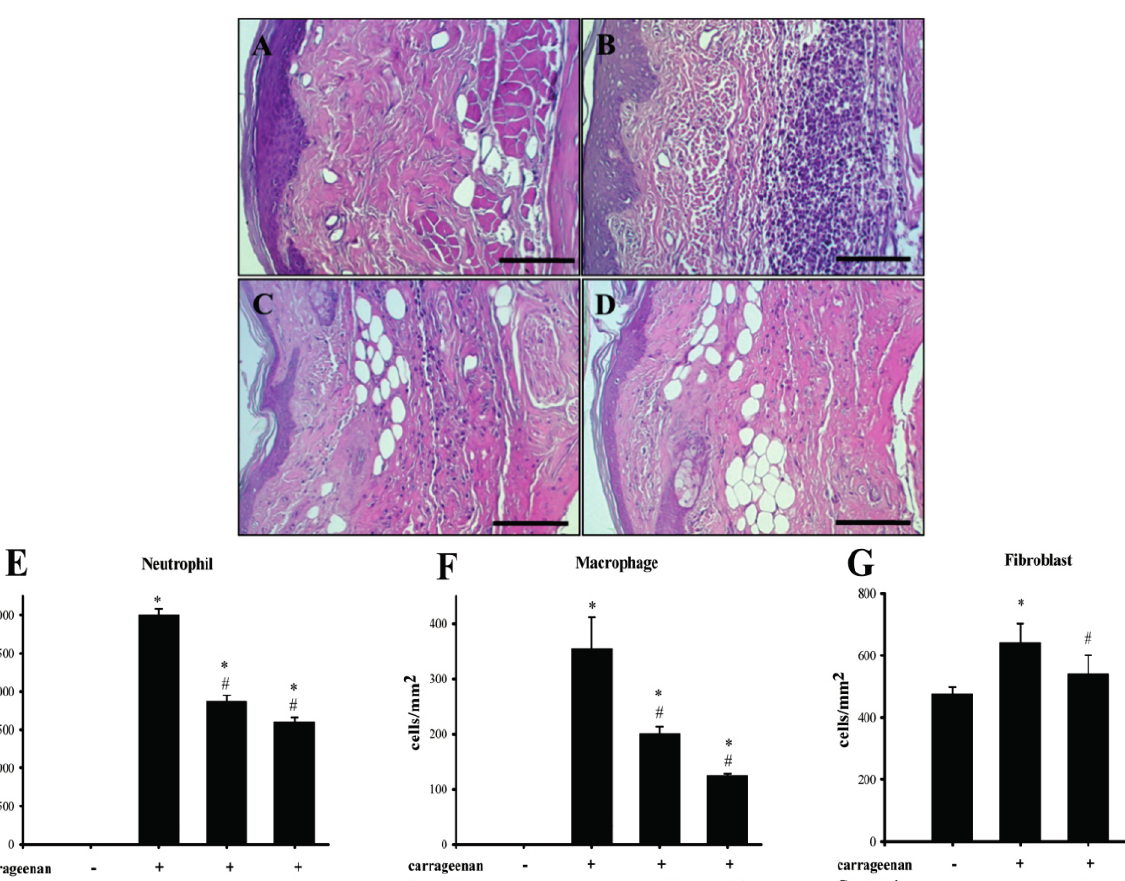
Figure 8. Histopathologic analyses of the effects of comaparvin on cell infiltration in carrageen-injected paws. ( A ) Vehicle group ( B ) Carrageenan-alone group ( C ) Pre-treatment group ( D ) Post-treatment group. Pre-treatment or post-treatment of comaparvin (30 mg/kg) appeared to attenuate carrageenan-induced upregulation of immune cells. Numbers of neutrophils ( E ); macrophages ( F ); and fibroblasts ( G ) were analyzed in paw tissue from each group. Pre, comaparvin pre-treatment at 1 h before carrageenan injection. Post, comaparvin post-treatment at 4 h after carrageenan injection. Scale bar = 200 μ m. Data are the mean ± SEM values. * p < 0.05, significant difference compared with the control group. # p < 0.05, significant difference compared with the vehicle